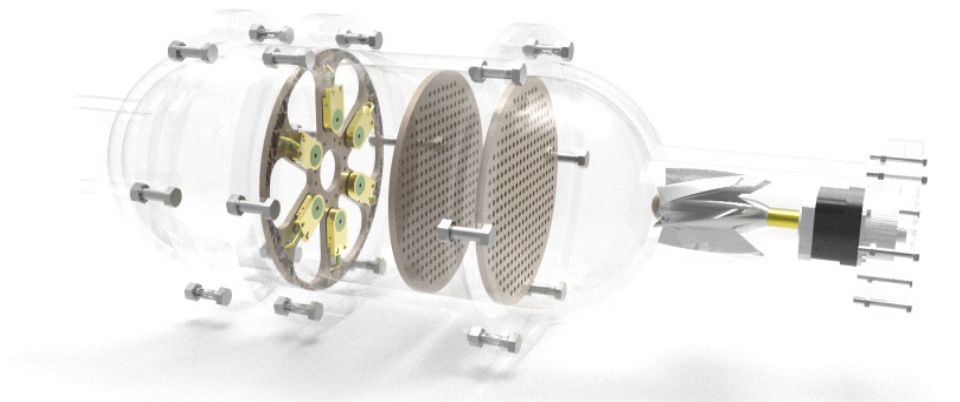
Figure 16. The overall design of the electronic nose.